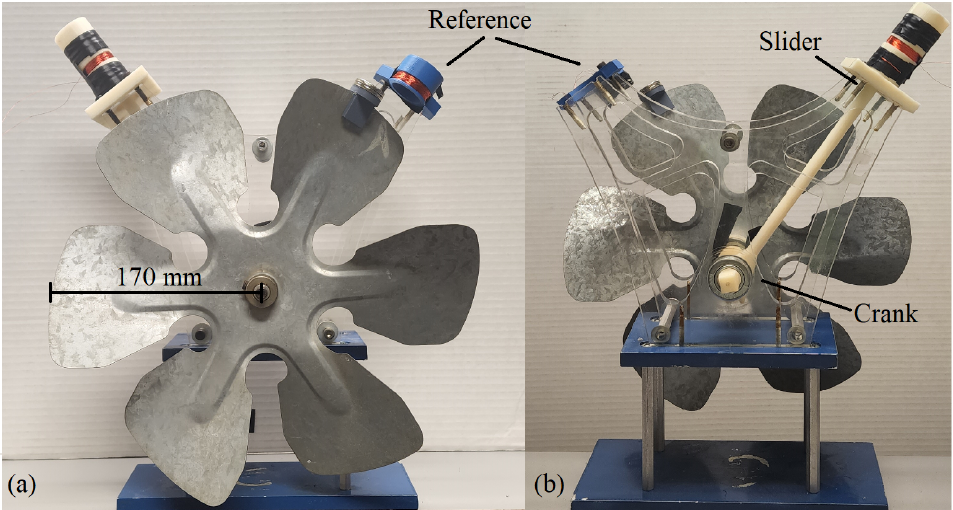
Figure 4. ( a ) Front section of the harvester which includes the crank-slider mechanism, along with the reference harvester as indicated in the style presented in Figures 2 and 3. ( b ) Back section showing the crank-slider